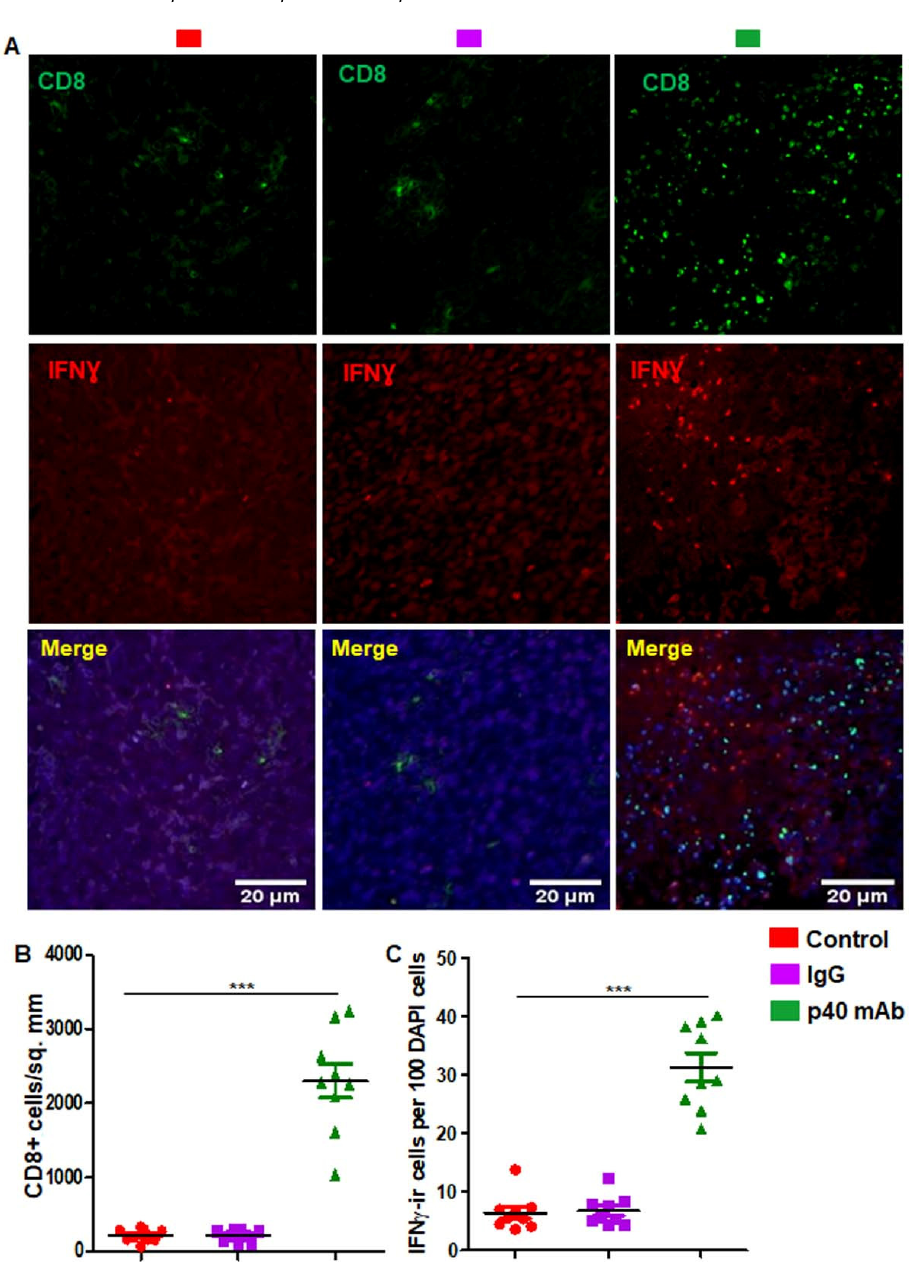
( C ) T cells were monitored in single cell suspensions by FACS using a BD LSRFortessa™ cell analyzer. Percentages of human CD4 + CD8 + ( D ), CD4 + IFN γ + ( E ) and CD8 + IFN γ + ( F ) T cells were calculated. Results are mean ± SEM of five mice ( n = 5) per group (one analysis per mouse). Levels of human IFN γ ( G ) and IL-10 ( H ) were measured in TNBC homogenates of all groups ( n = 5) of mice by